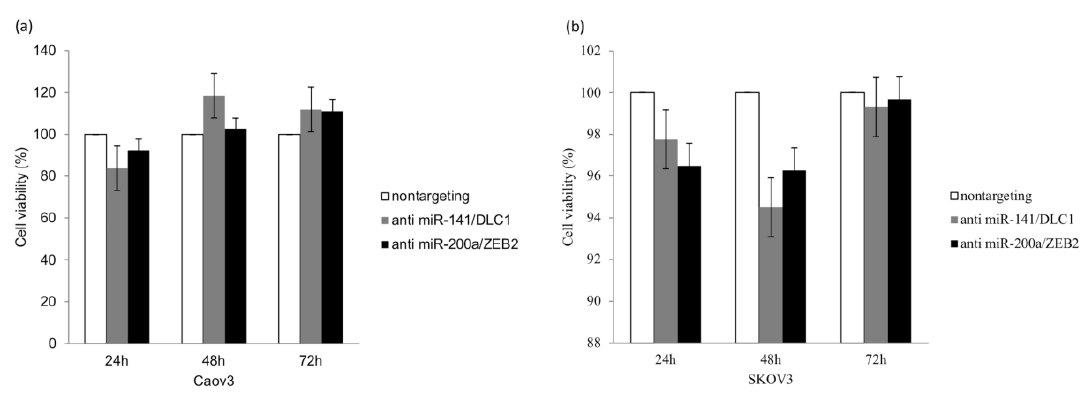
Figure 4. Relative expression of DLC-1 and ZEB2 increased following treatment with miRNA inhibitors. ( a ) In Caov3 cells, the relative expression of DLC-1 and ZEB2 increased after 72 h of transfection with anti-miR-141 and anti-miR-200a, respectively. ( b ) Similarly, miR-141 and miR-200a inhibition in SKOV3 cells led to increased DLC-1 and ZEB2 expression, respectively, after 72 h. Statistical analysis was performed using a student’s t -test. The graph represents the mean ± standard error of duplicate experiments.